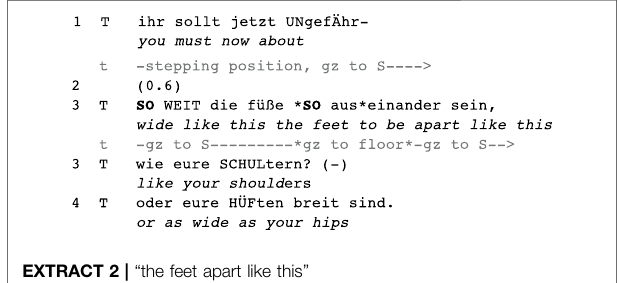
FIGURE 4 | Continuous gaze at